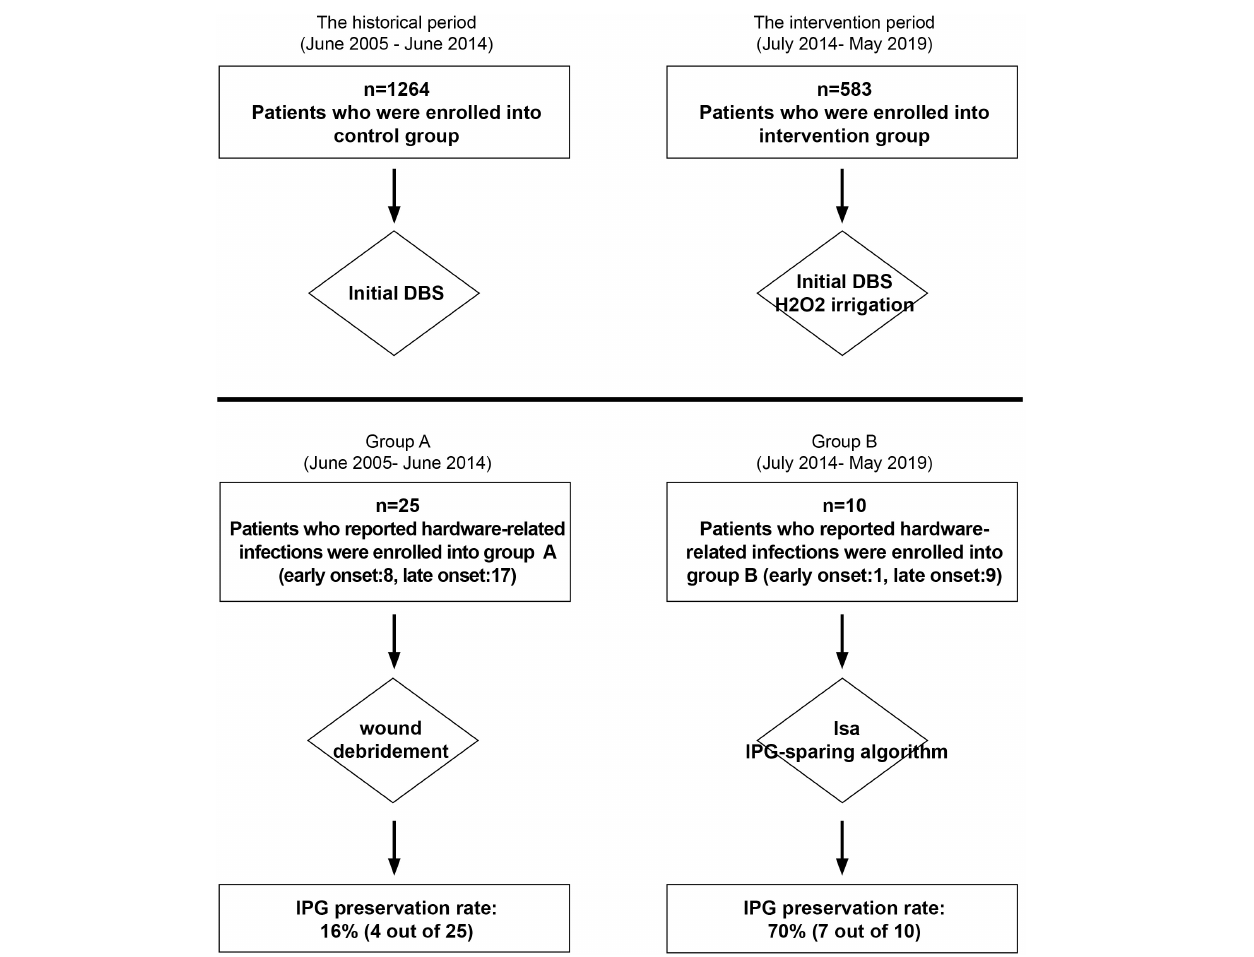
FIGURE 1 | Enrollment of patients and flow diagram. DBS, deep brain stimulation; IPG, implantable pulse generator; H 2 O 2 , 3% solution of hydrogen peroxide, which was used at the IPG pocket to prevent the early and primary IPG